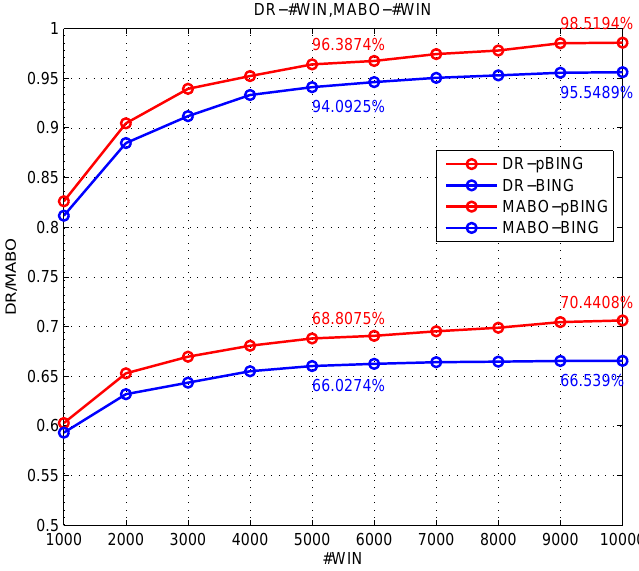
Figure 7. Tradeoff between #WIN and DR/MABO on the dataset LARGE-FIELD-RSIs when #WIN varied from